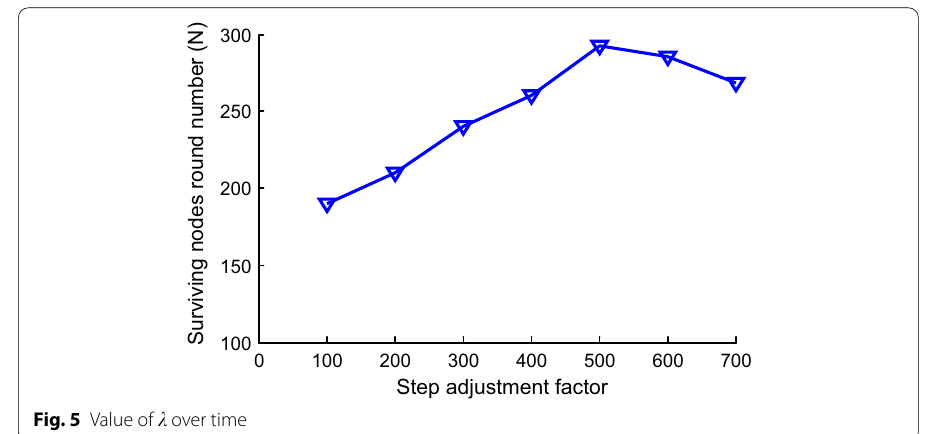
Fig. 5 Value of (cid:31) over time